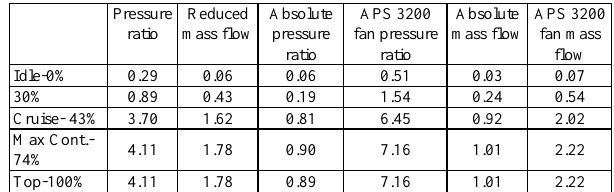
Table 15. Parameter of APS 3200 V = 0.44 Ma, H = 0 m